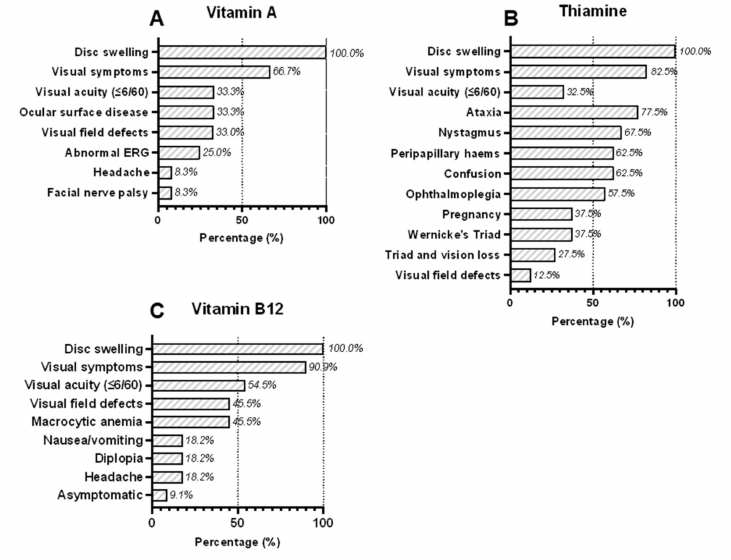
Figure 1. Clinical symptoms and signs of patients presenting with bilateral optic disc swelling associated with deficiencies in ( A ) vitamin A, ( B ) thiamine, and ( C ) vitamin